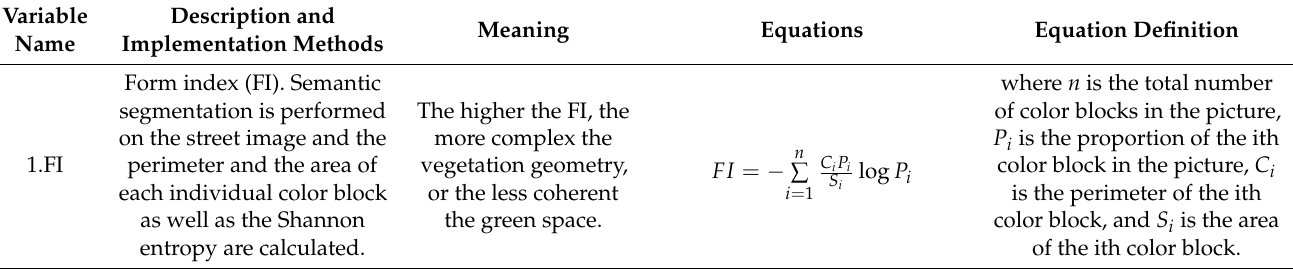
Table 1. Definition and equation of space morphology indicators of street